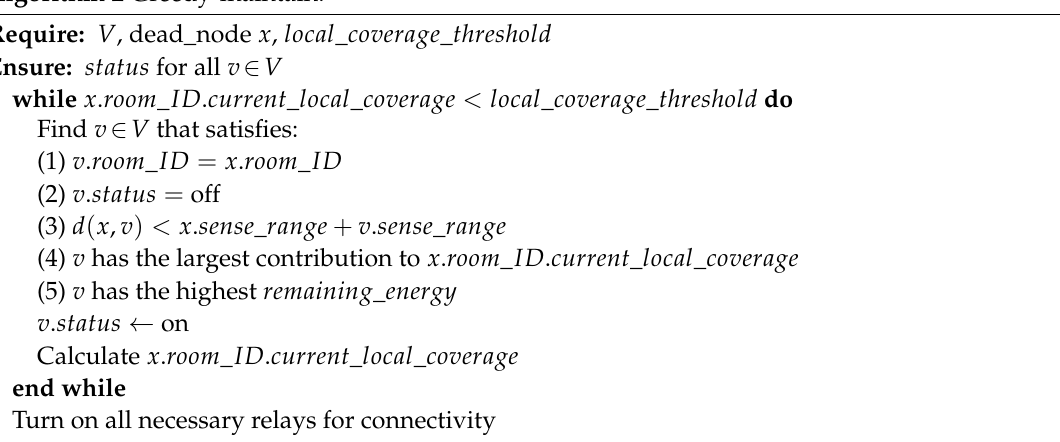
Algorithm 2 Greedy-maintain.